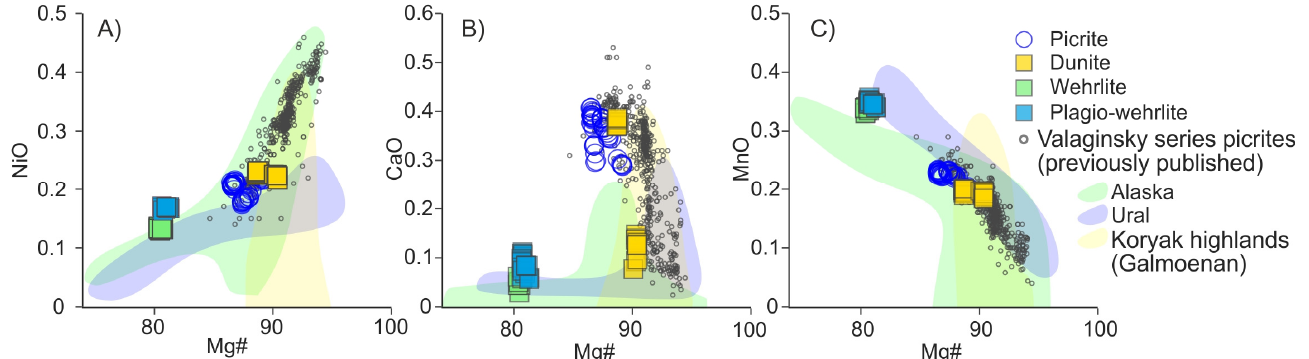
Figure 6. Chemical variation plots of olivine compositions from the studied rocks, including previously published data on the Valaginsky series volcanics (both Tumrok and Valaginsky ridge occurrences) [54,61]. ( A ) Mg#-NiO plot (where Mg# = Mg/(Mg + Fe) atomic %); ( B ) Mg#-CaO plot; ( C ) Mg#-MnO plot. Compositional fields for Alaska (Kane Peak, Blashke Islands, Slat Chuck, Union Bay) [6], Ural (Nizhniy Tagil, Svetly Bor, Kytlym) [18,48], UA-complexes, and Galmoenan complex [28] are given for comparison.